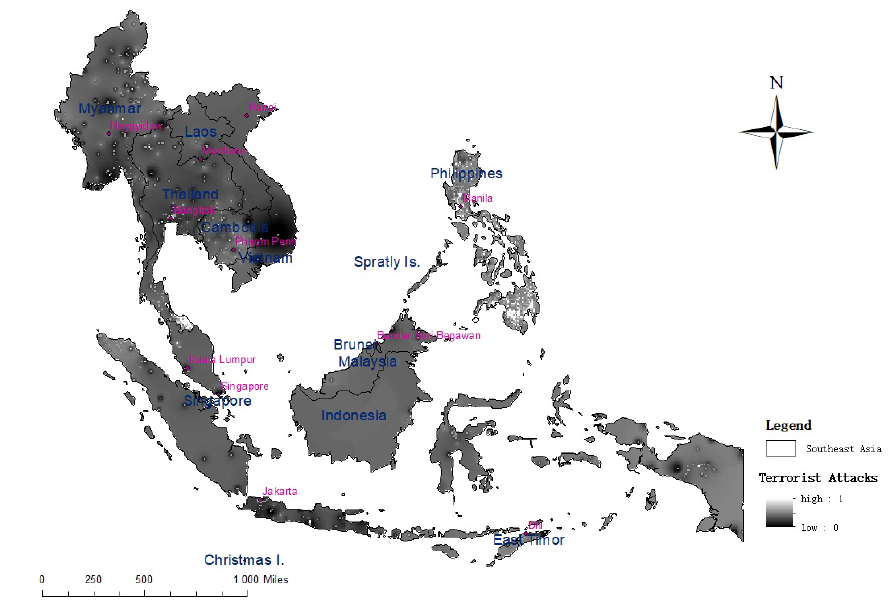
Figure 8. Results of the terrorist attack risk assessment.